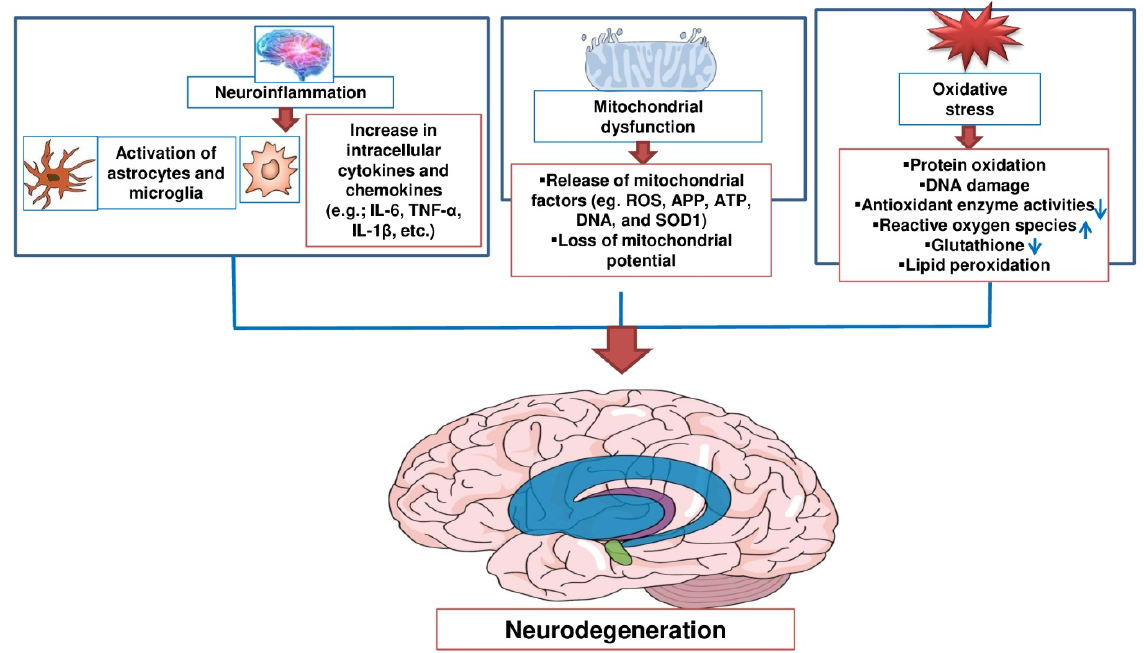
Figure 1. Different biological processes, including oxidative stress and neuroinflammatory and mitochondrial dysfunctions, have been involved in the development and pathogenesis of NDs.